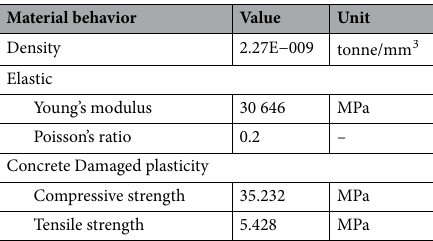
Table 2. Behavior of concrete in finite element analysis.